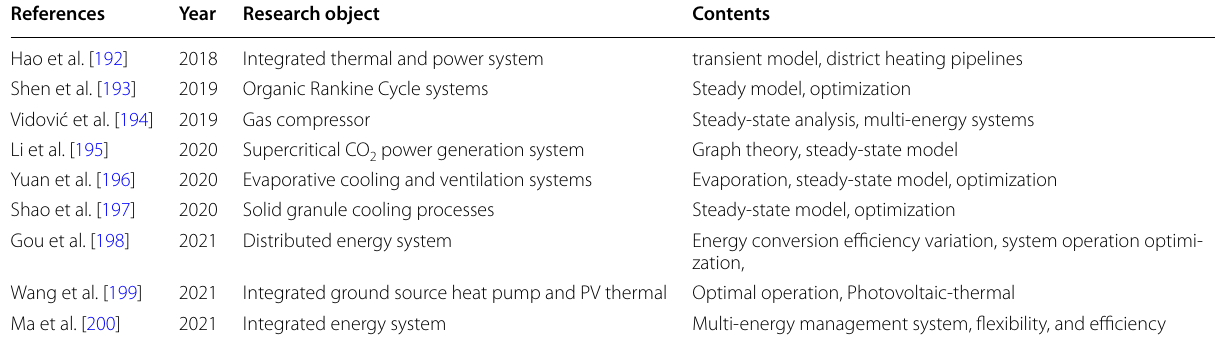
Table 4 Research and applications of heat current